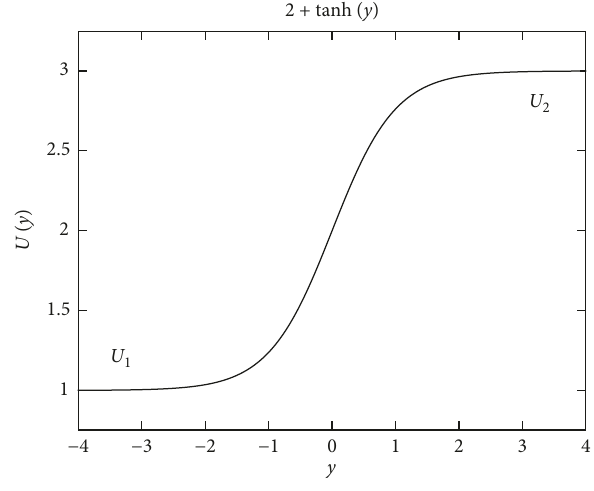
Figure 1: Base flow velocity distribution.